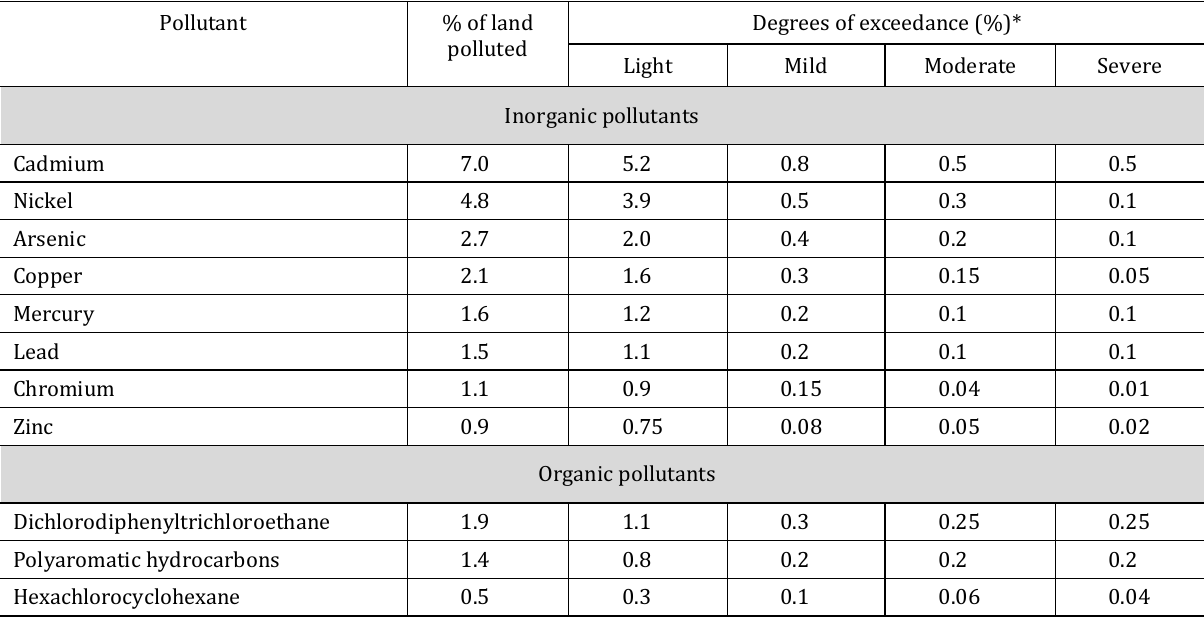
Table 1. Amount of land polluted with inorganic and organic pollutants (Source: MEP, 2014) Pollutant % of land Degrees of exceedance polluted